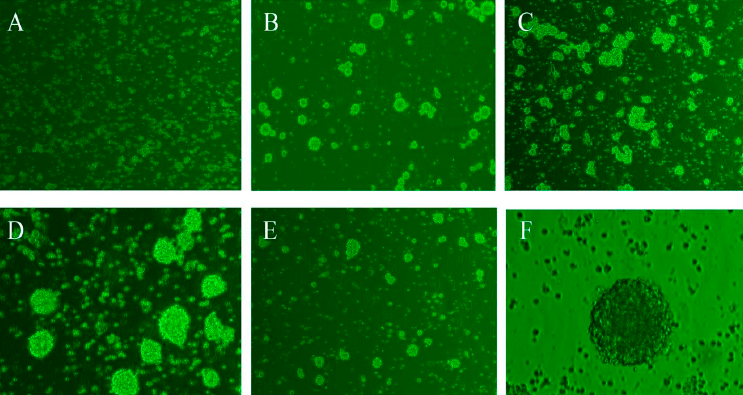
Figure 1. Growth state of NSCs. ( A ) Primary NSCs (100×); ( B ) NSCs cultured for 48 h (100×); ( C ) NSCs cultured for 72 h (200×); ( D ) NSCs needed to be subcultured (200×); ( E ) NSCs after subculturing (100×); ( F ) Neurospheres (400×).